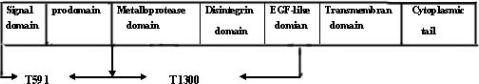
Structure of TACE.